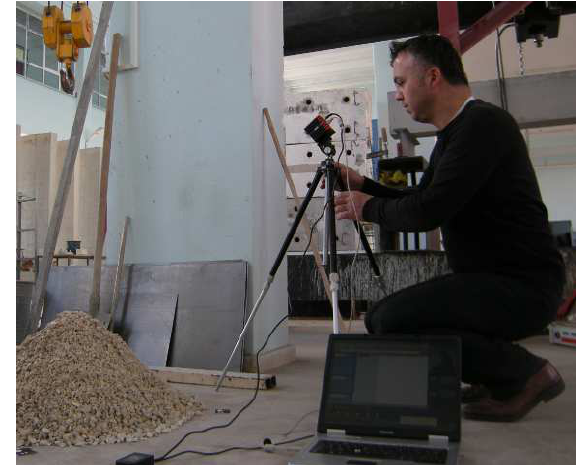
Figure 2. The volume measurement of the gravel pile by SR4000